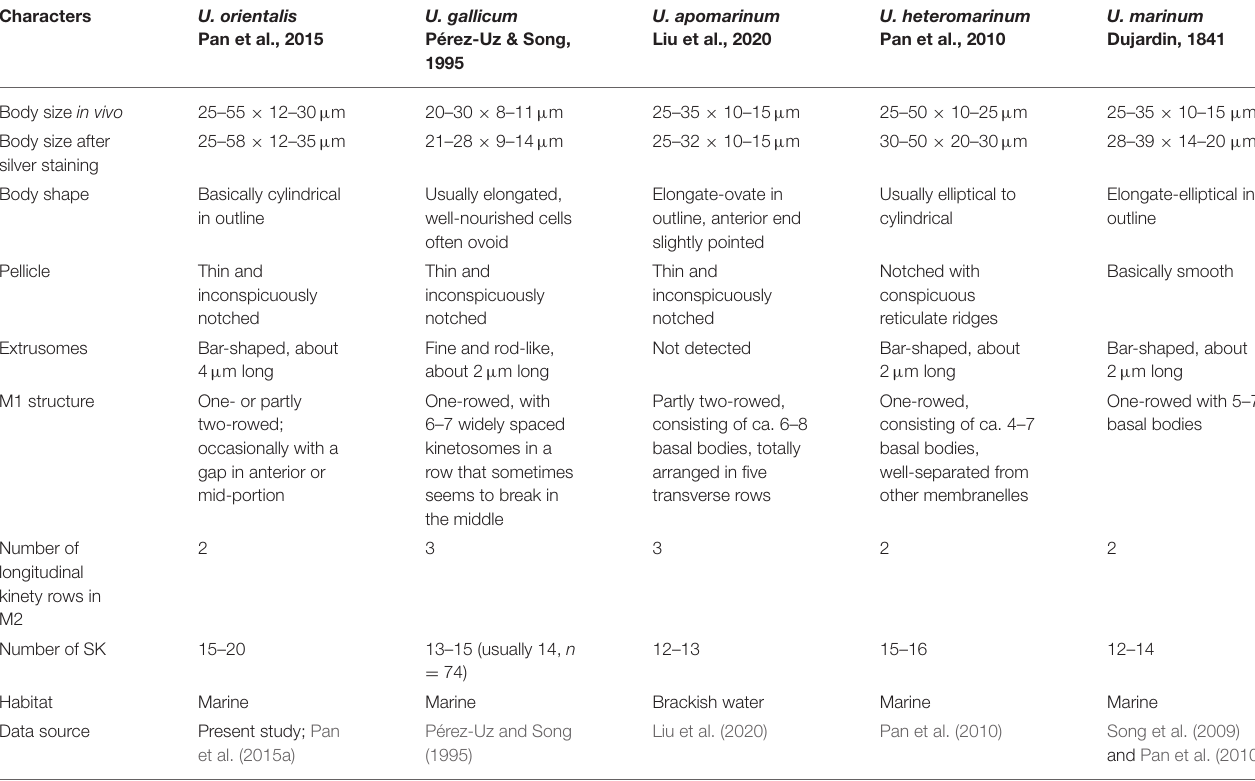
TABLE 4 | Comparison of Uronema orientalis Pan et al., 2015 with selected